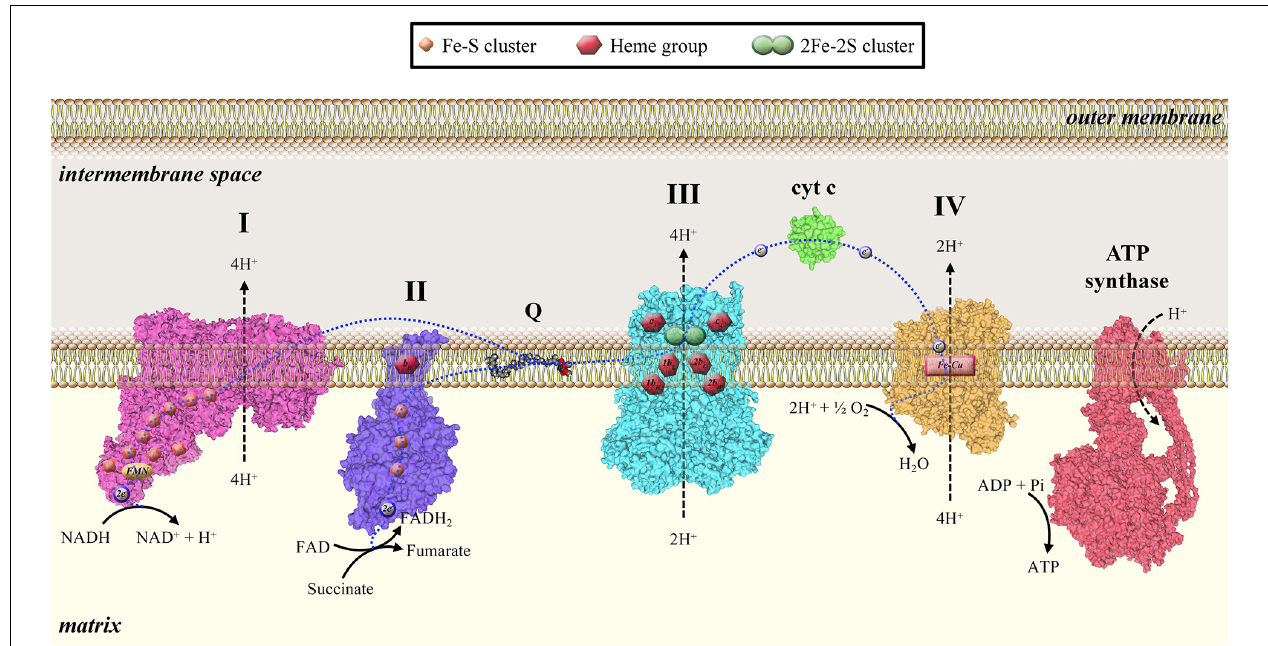
FIGURE 1 | Mitochondrial electron transport chain consists of four complexes: Complex I (NADH-coenzyme Q reductase), Complex II (succinate dehydrogenase), Complex III (coenzyme Q-cytochrome c reductase), and Complex IV (cytochrome c oxidase). Complexes I, III, and IV establish the proton gradient across the IMM for ATP synthesis by ATP